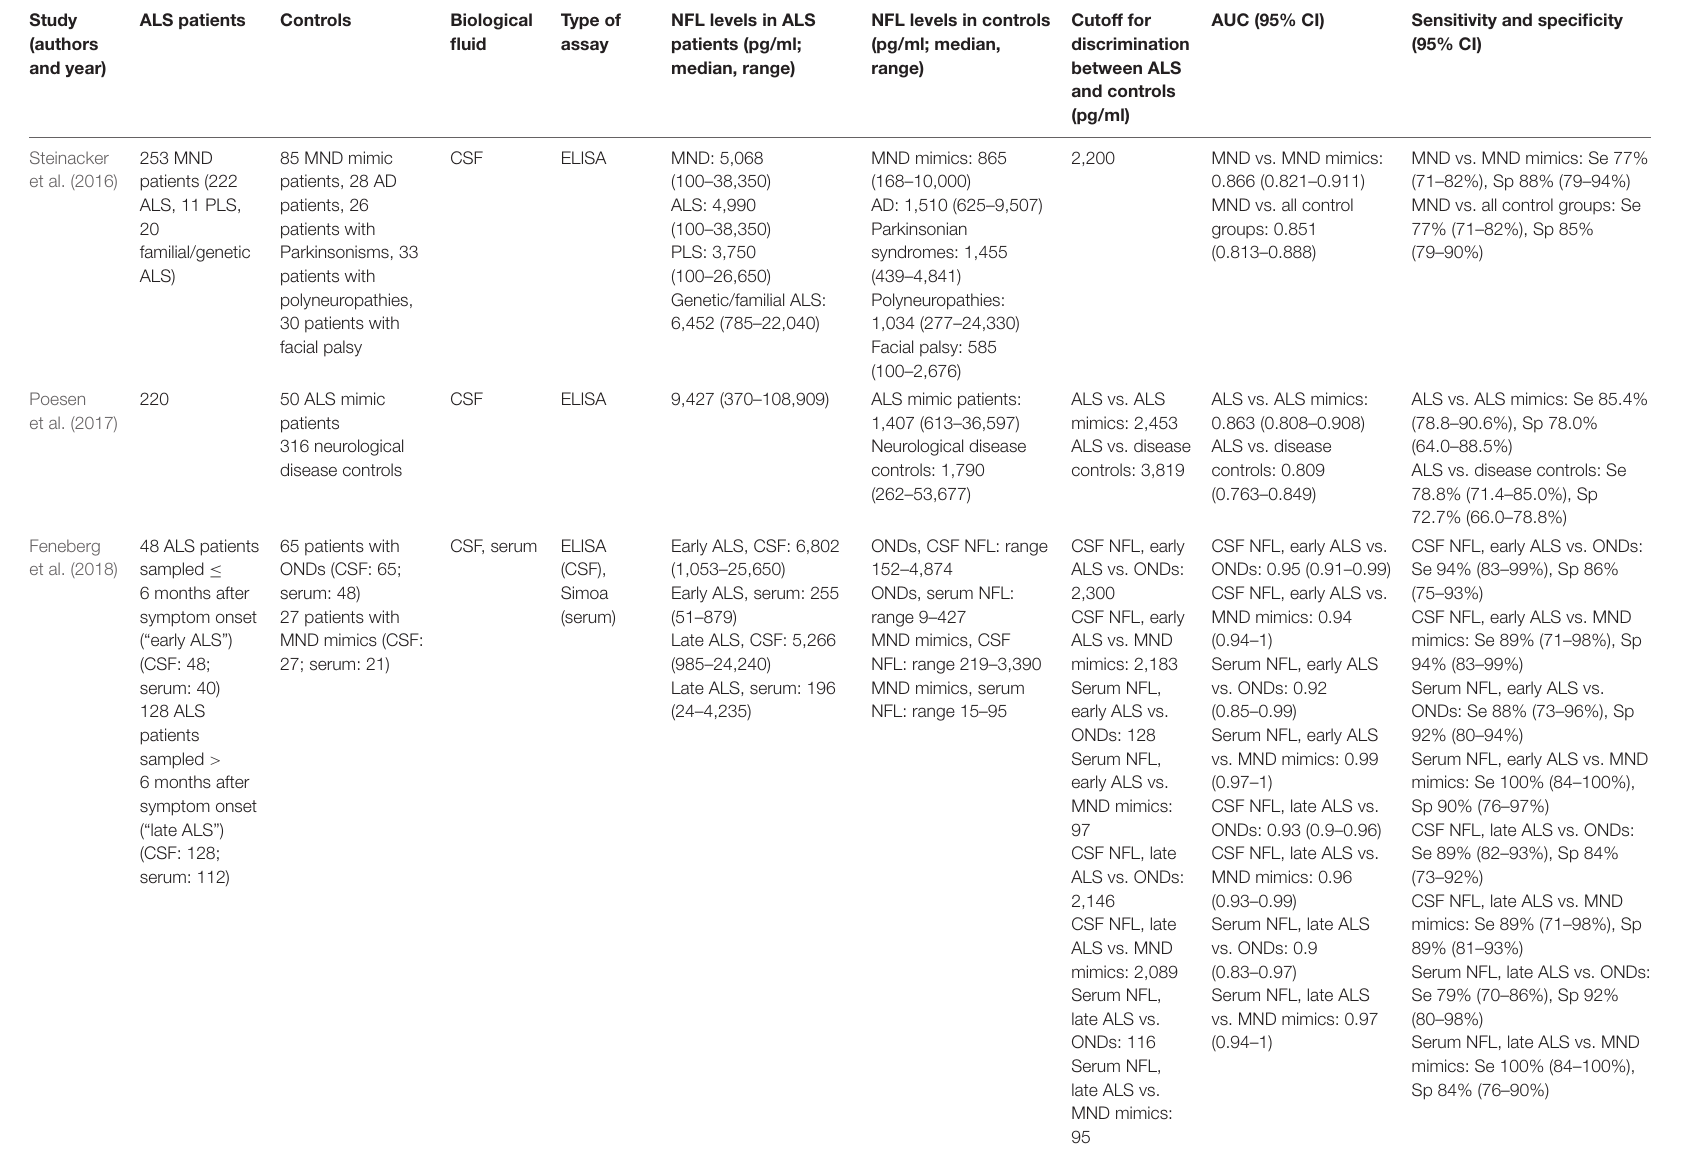
TABLE 1 | Representative studies on NFL as diagnostic biomarker for